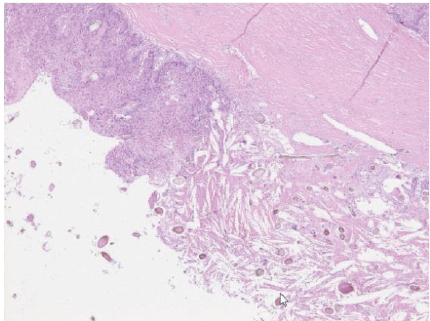
Figure 4: Histologically, squamous cell carcinoma was observed inside the cyst (left side of the picture). Granulation tissue contain- ing hair was also found (right side of the picture) (H&E staining, × 100).